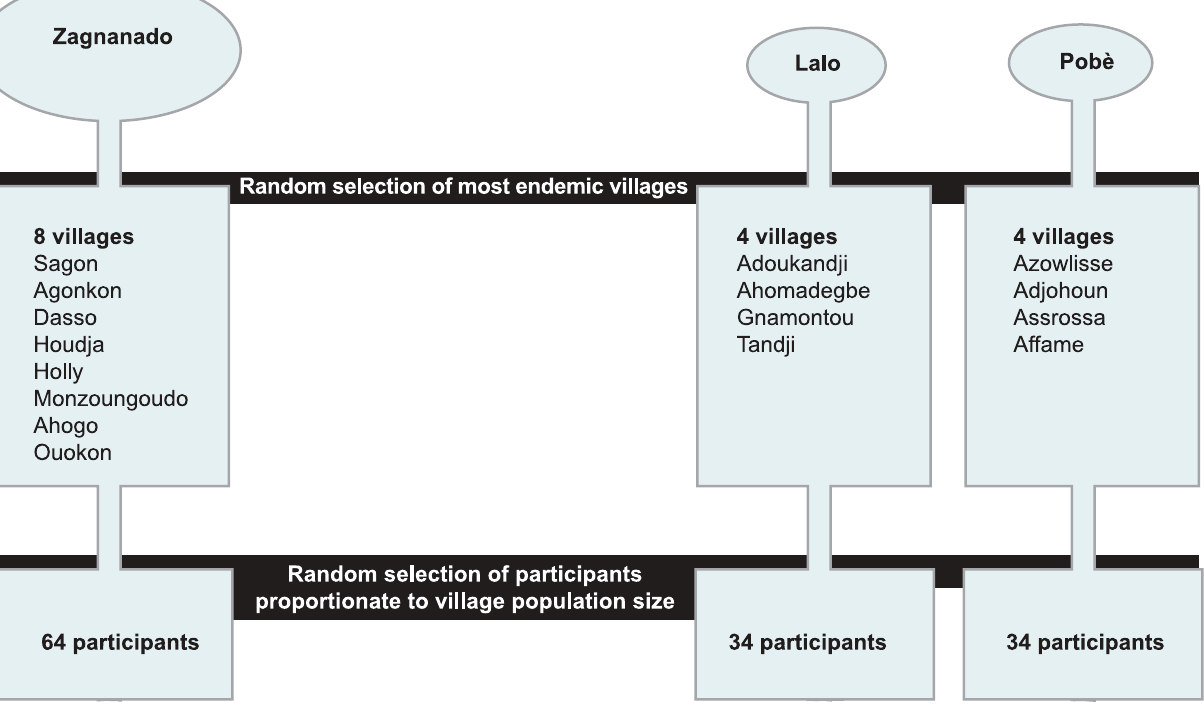
Figure 2. A multistage sampling procedure. doi:10.1371/journal.pntd.0002014.g002 ulcer (figure 3), all BU-pictures published by the WHO. Participants were asked to imagine that their skin looked like the skin in the pictures. After showing the picture, the question ‘‘What would you do?’’ was asked, followed by the five possible answers;